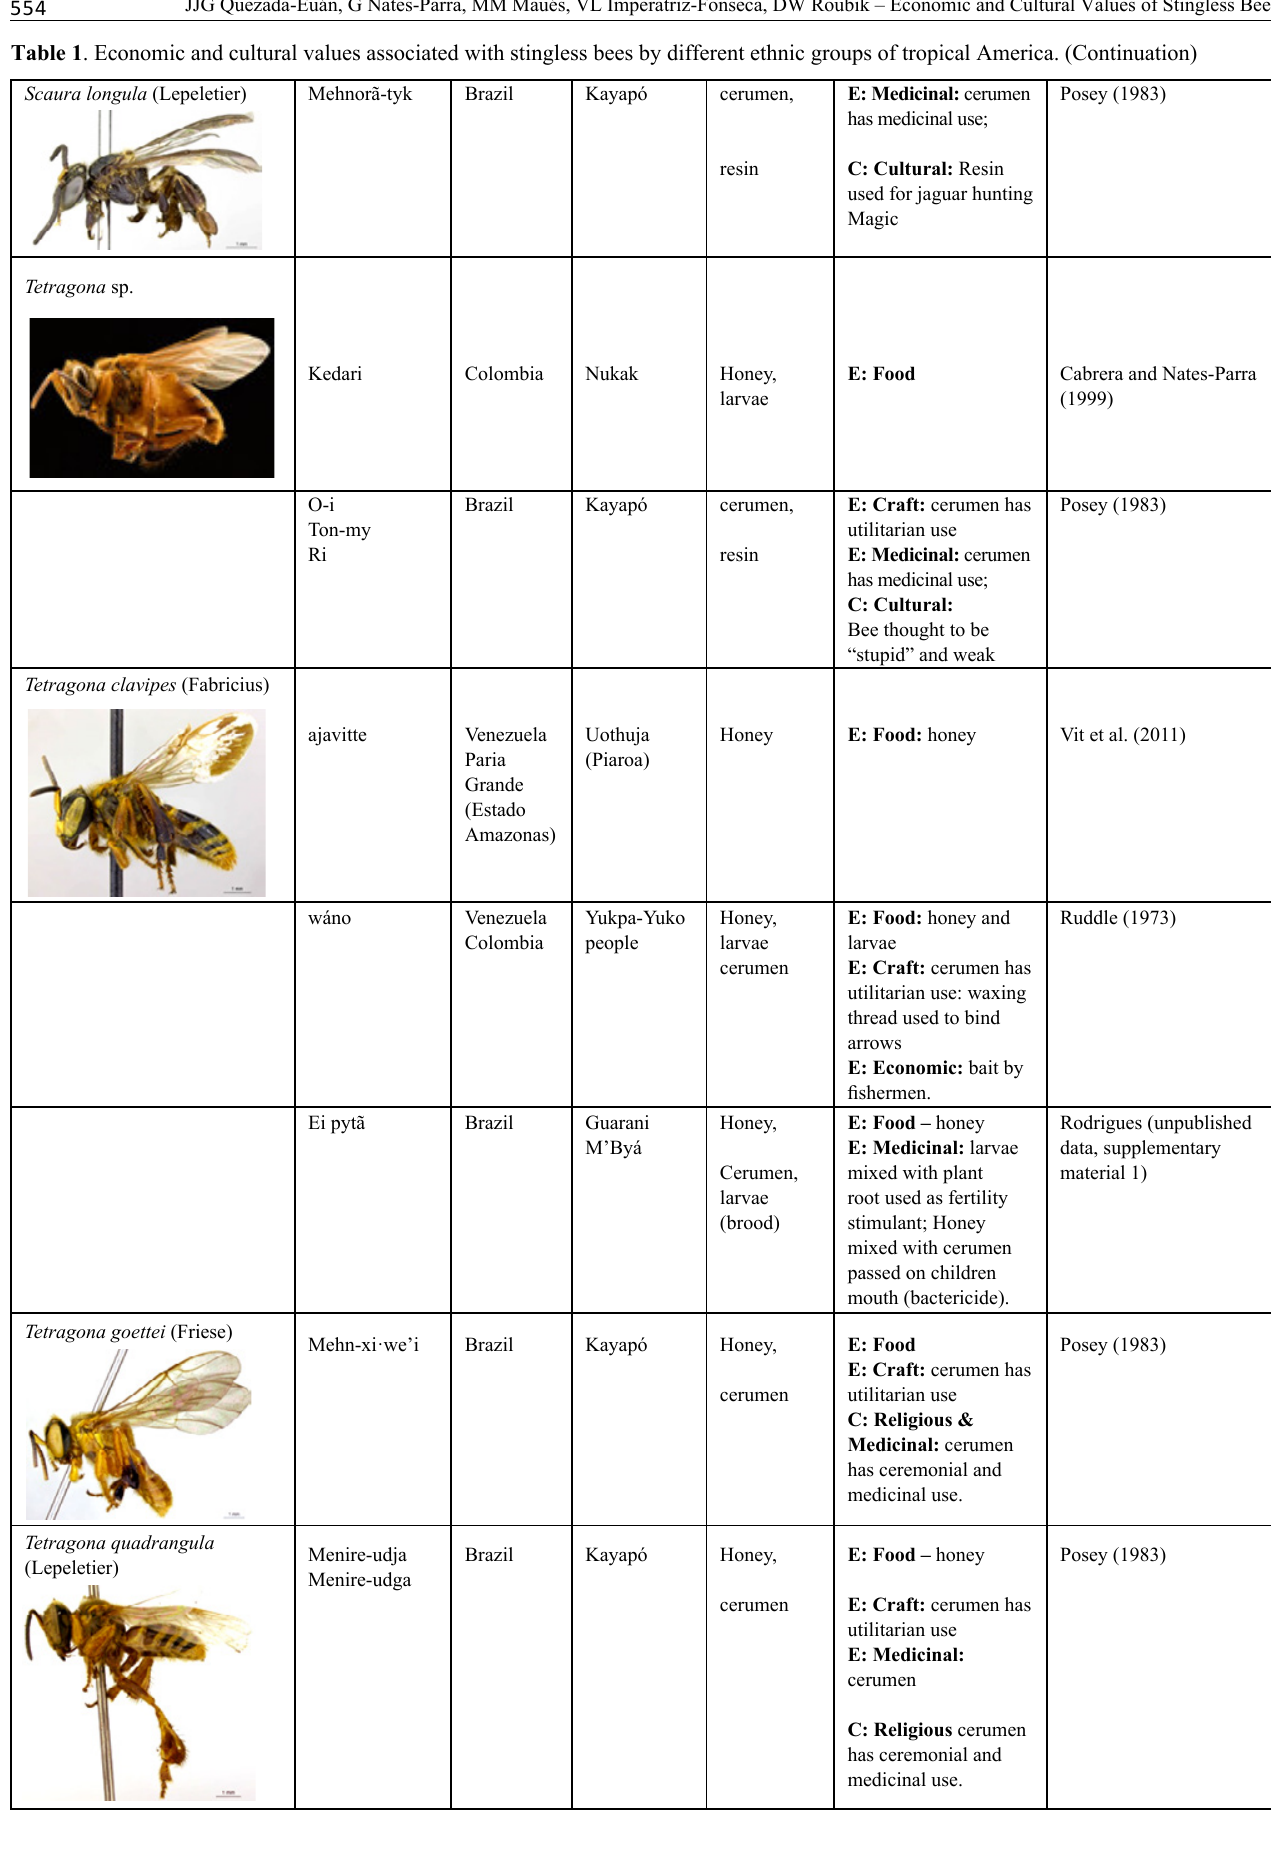
Posey (1983) E: Medicinal: cerumen has medicinal use; resin C: Cultural: Resin used for jaguar hunting Magic